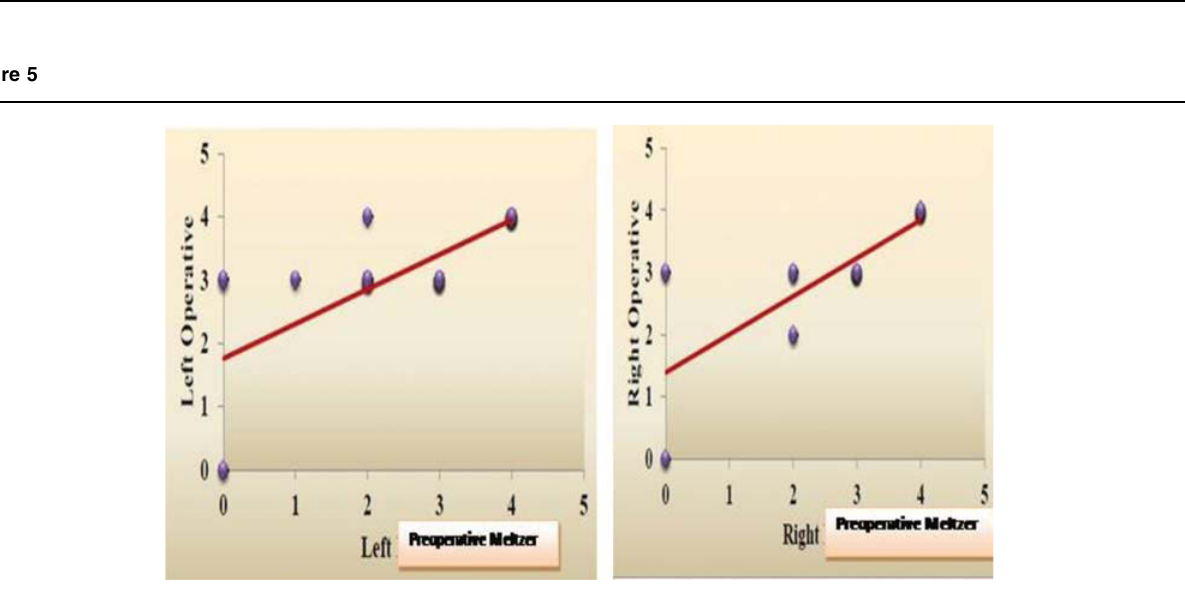
There wasa highly significantpositivecorrelation between preoperative endoscopicandLund – Mackay staging scoreswith a P valueof lessthan 0.001, and the ( r ) Spearman correlation coefficient was (right side = 0.768 and left side = 0.782).